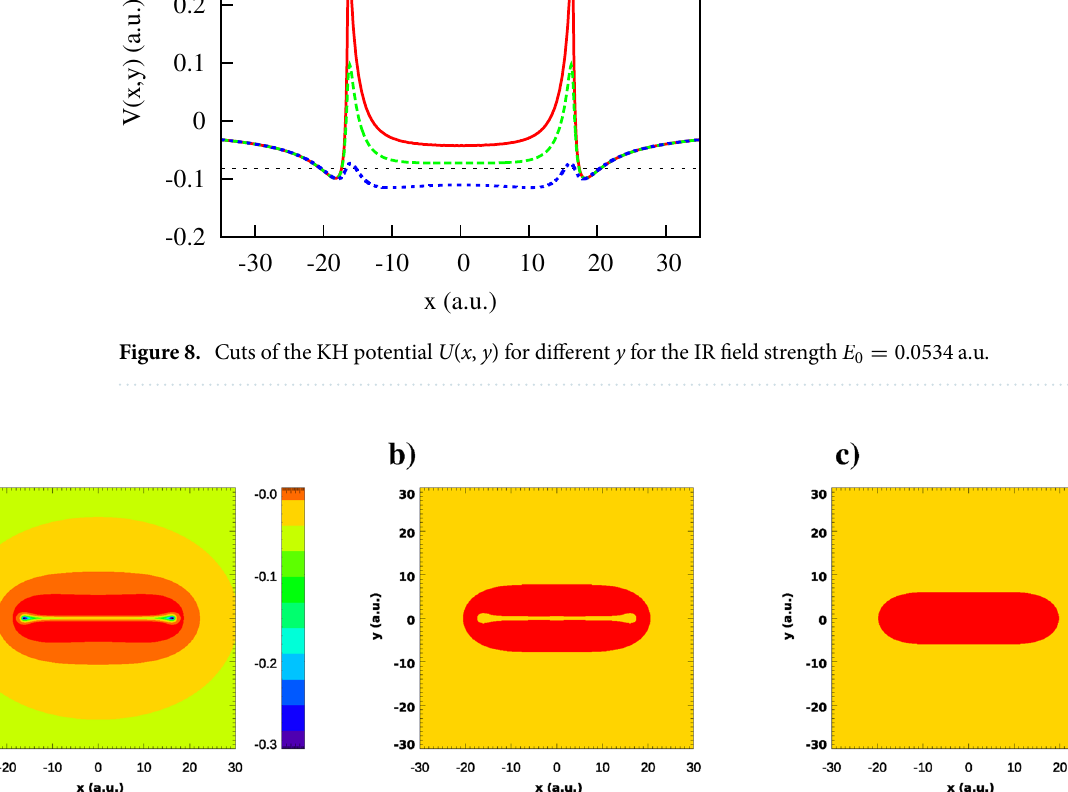
Figure 9. ( a ) The electron kinetic energy T E 0 0.0534 a.u. ( b ) Classically allowed area (in red) in the ( x , y )-plane for E 0 = allowed area (in red) in the ( x , y )-plane for the same field parameters and atomic Coulomb